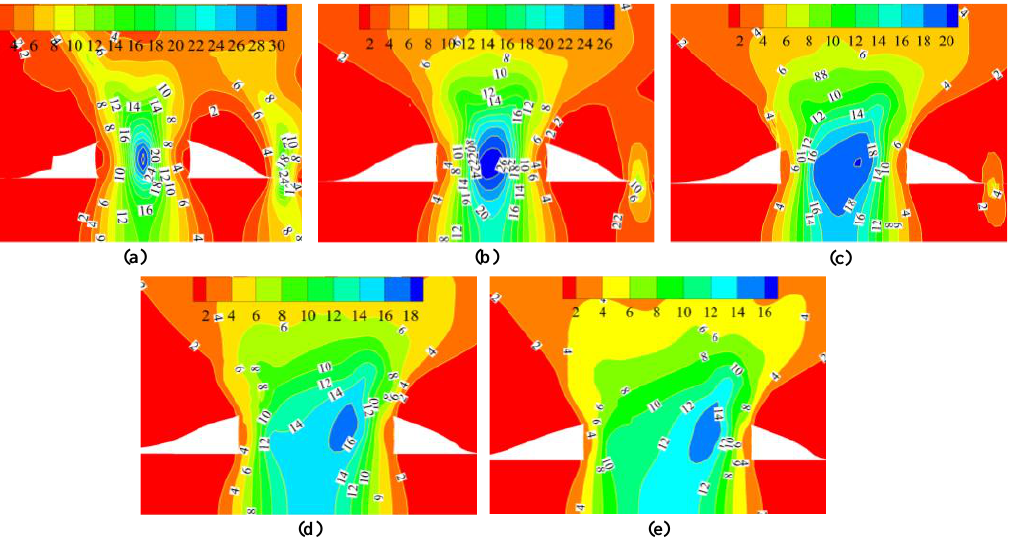
Figure 5. Nephogram of vertical stress distribution of coal pillars with different widths during mining: ( a ) 7 m; ( b ) 9 m; ( c ) 11 m; ( d ) 13 m; ( e ) 15 m.